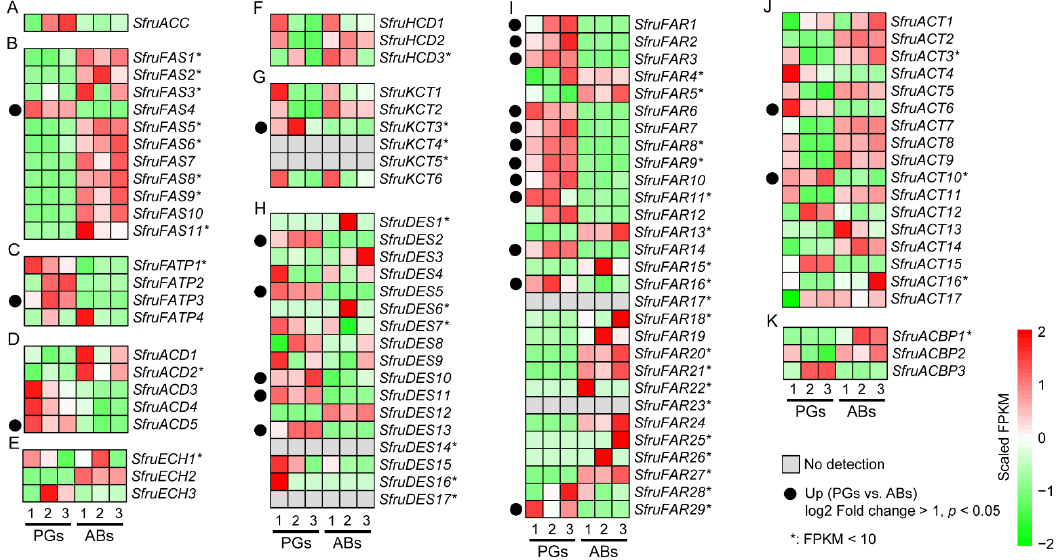
Figure 4. Expression profiles of the candidate sex pheromone biosynthesis genes in S. frugiperda . ( A ) ACC; ( B ): FASs; ( C ): FATPs; ( D ): ACDs; ( E ): ECHs; ( F ): HCDs; ( G ): KCTs; ( H ): DESs; ( I ); FARs; ( J ): ACTs; ( K ): ACBPs.